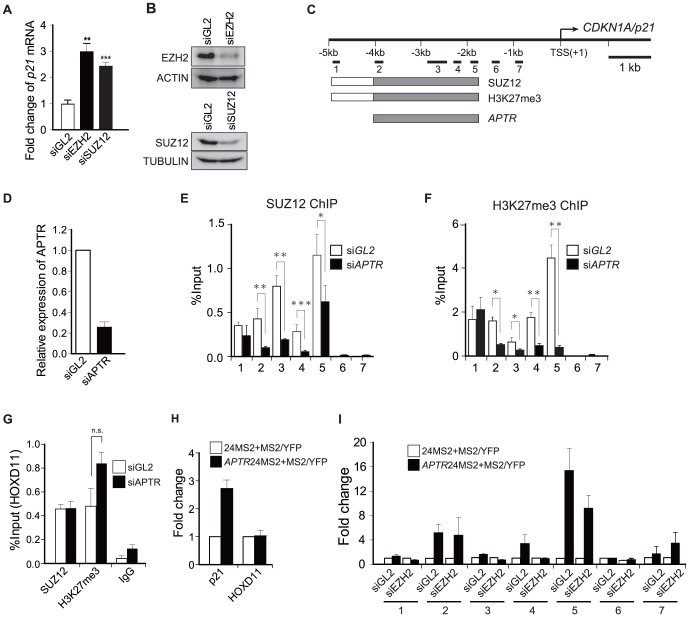

APTR regulates p21 epigenetically via the PRC2 complex.(A) Q-RT-PCR shows induction of p21 mRNA normalized to GAPDH after EZH2 or SUZ12 knockdown on the left. Fold change compared to siGL2-transfected cells. Mean ±s.e.m, n>6, **: P = 0.006. ***: P<0.0001). (B) Endogenous EZH2 and SUZ12 were analyzed by immunoblot after EZH2 or SUZ12 knockdown as a control for Figure 5A. (C) Schematic of p21 promoter and primer pairs for CLIP PCR (as in Figure 3F). Boxes: binding of indicated proteins/RNA in control cells (Figure 3F, 5E–F). Grey areas: regions where binding is downregulated by siAPTR#2. (D) qRT-PCR shows APTR knockdown efficiency by siAPTR#2 in Figure 5E–G. (E–F) ChIP of SUZ12 or H3K27me3 on the p21 promoter in 293T cells transfected by either siGL2 or siAPTR#2. X-axes: primer-pairs 1–7 in Figure 3F. Y-axes: %Input values were presented. Mean ±s.e.m. n = 6. (G) ChIP of SUZ12 or H3K27me3 on the HOXD11 locus in 293T cells transfected by either siGL2 or siAPTR#2. X- axis: antibodies used for ChIP. Y-axis: % input of HOXD11 locus in precipitates. (n.s.: not significant, Mean ±s.e.m. n = 6) (H) CLIP of MS2-APTR or MS2 RNA alone in the p21 promoter (primer-pair 2 in Figure 3F) and the HOXD11 locus. Mean ±s.e.m. n = 6. Y-axis shows amount of specific DNA in the precipitate normalized to that in the CLIP of MS2 alone. (I) CLIP of MS2-APTR or MS2 RNA alone on the p21 promoter in 293T cells transfected by siGL2 or siEZH2. X-axes: primer-pairs 1-7 in Figure 3F. Y-axis: amount of specific DNA in the precipitate normalized to that in CLIP of MS2 alone. Mean ±s.e.m. n = 3.